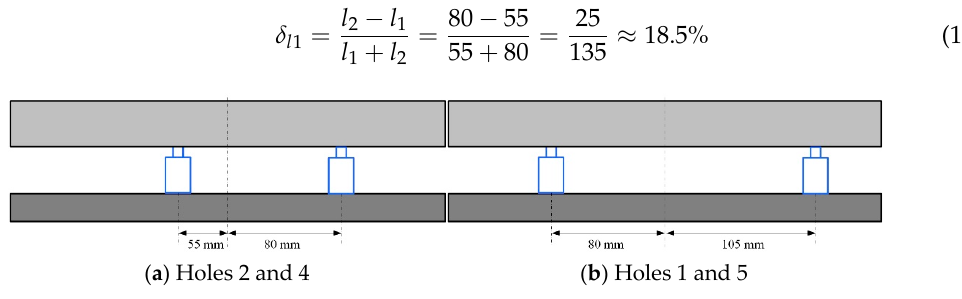
Figure 13. Schematic diagram of the different deviations.